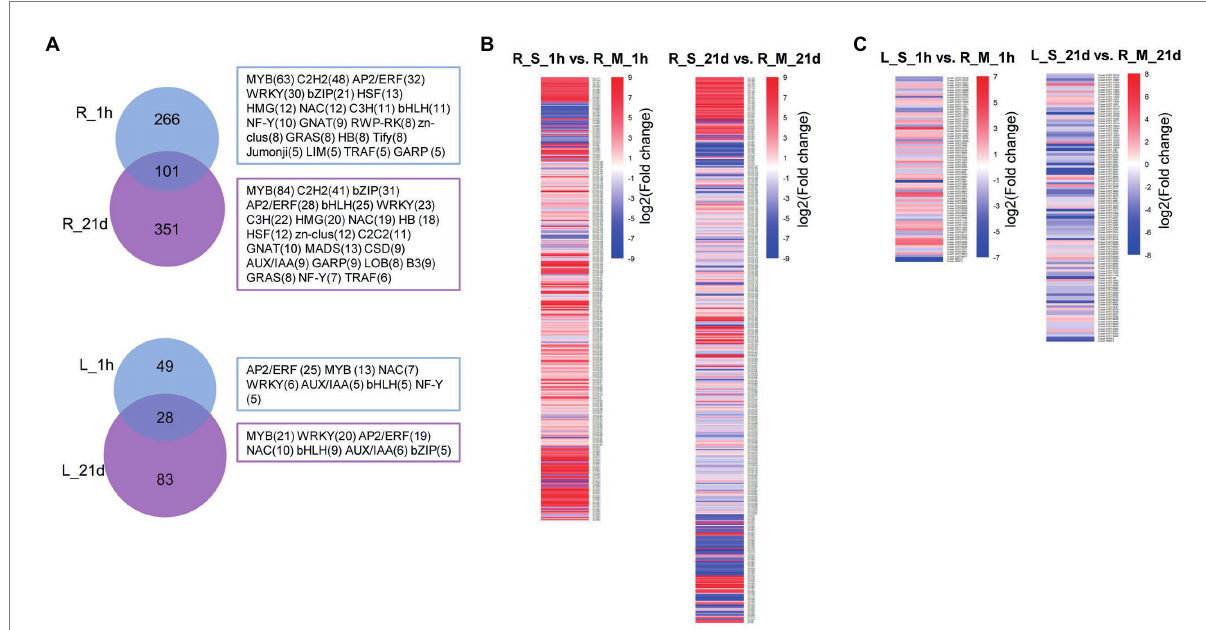
FIGURE 8 Analysis of differentially expressed TFs in roots and leaves of S. portulacastrum. (A) Venn diagrams for salt-induced TFs in roots and leaves of S. portulacastrum. R_1h and R_21d means differentially expressed TFs in roots after salt treatment (400 mM Na) for 1 h and 21 days. L_1h and L_21d means differentially expressed TFs in leaves after salt treatment after 1 h and 21 days. The TF families and gene numbers ( n > 4) were shown in the right. (B) Expression analysis of the TFs in each